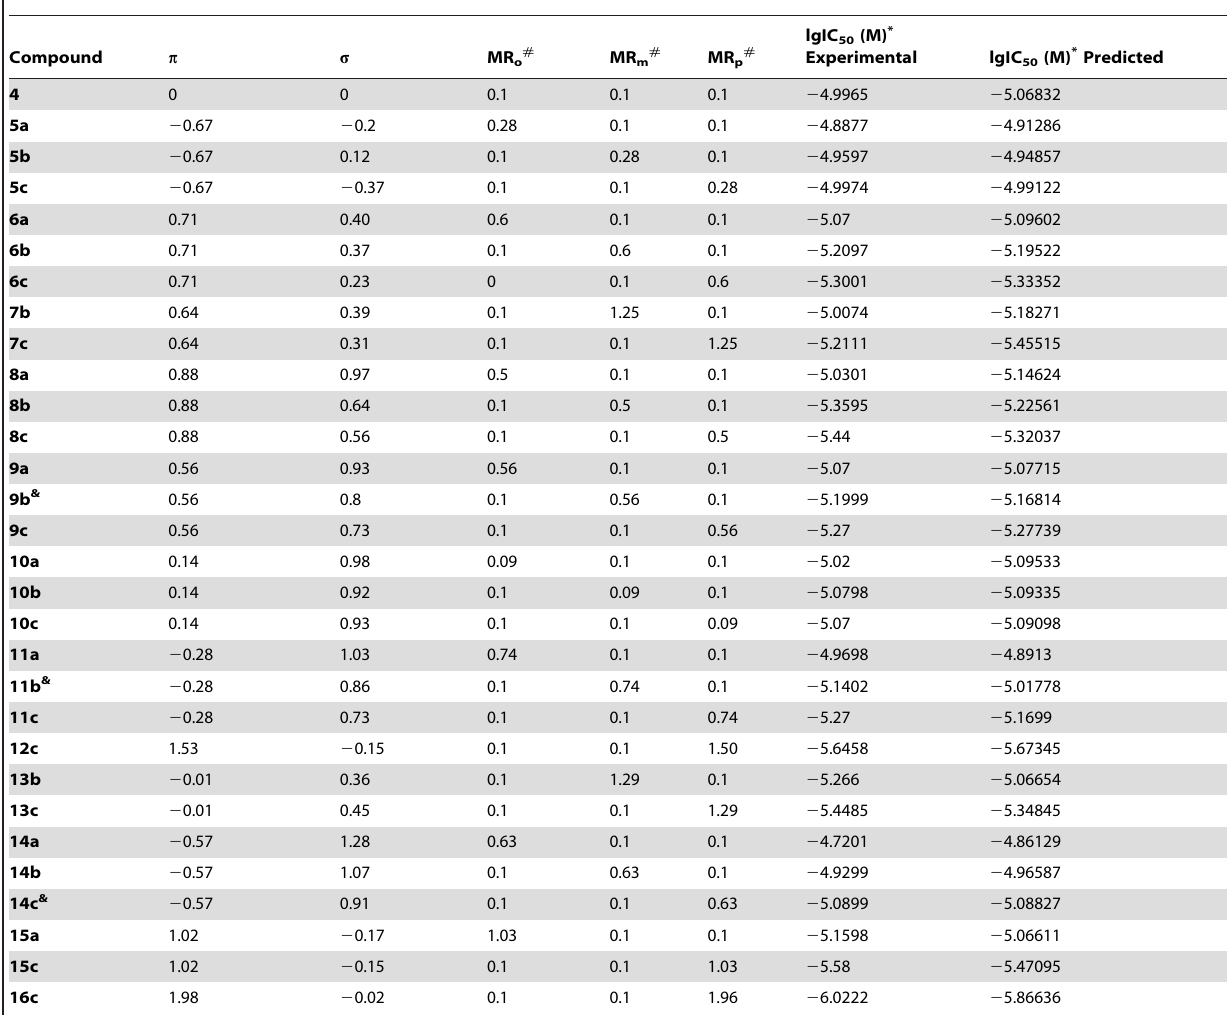
Table 1. Physicochemical properties and lgIC 50 of the